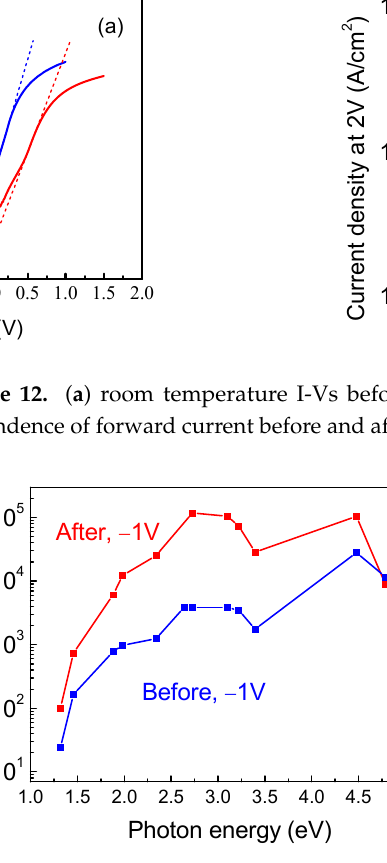
Figure 13. Photocurrent at − 1 V normalized by dark current for measurements before and after ir ‐ radiation.